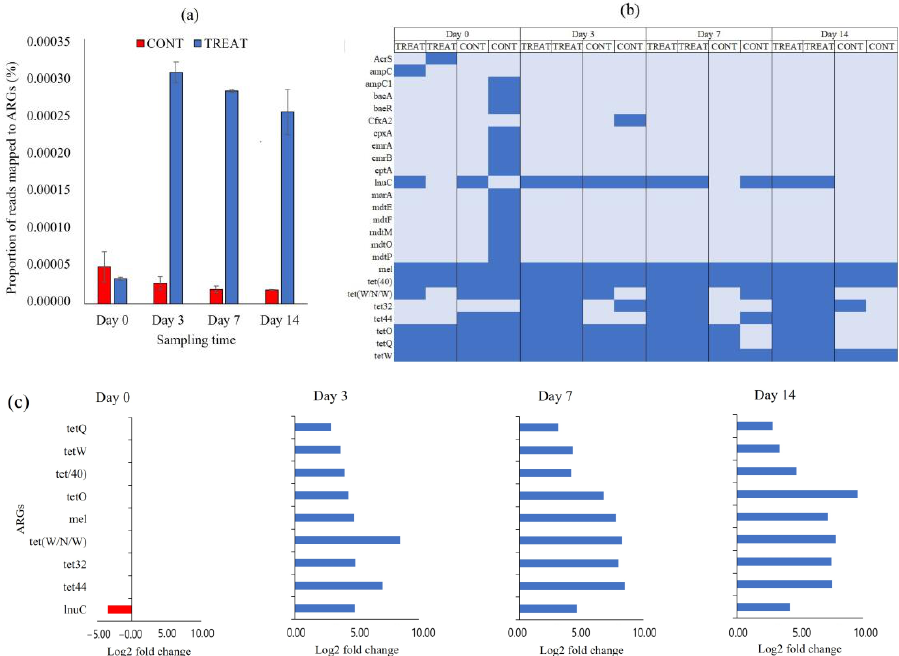
Figure 4. ( a ) The proportion of short sequencing reads mapped to antibiotic resistance genes (ARGs) in control (CONT) and oxytetracycline-treated (TREAT) cattle in fecal samples on days 0, 3, 7, and 14 following oxytetracycline administration. ( b ) Heatmap of absence (light blue) and presence (blue) of ARGs between CONT and TREAT samples throughout the experimental period. ( c ) Differentially abundant ( p < 0.05) ARGs in the fecal resistome between CONT and TREAT cattle 0, 3, 7, and 14 days after antibiotic treatment. ARGs in the y-axis are ordered from most abundant (top) to lower abundant (bottom) genes. Negative and positive log 2 fold change values are ARGs enrichments in CONT (red) and TREAT (blue) samples, respectively.